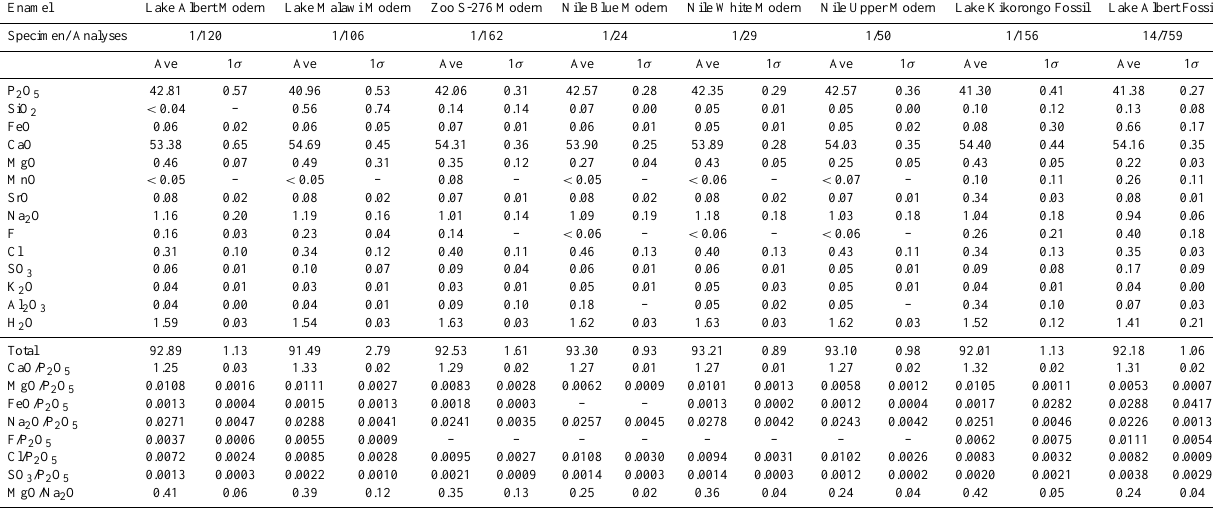
Table 1. Average chemical composition of enamel from modern and fossil hippopotamid molar teeth. Enamel LakeAlbertModern LakeMalawiModern ZooS-276Modern NileBlueModern NileWhiteModern NileUpperModern LakeKikorongoFossil LakeAlbertFossil Specimen/Analyses